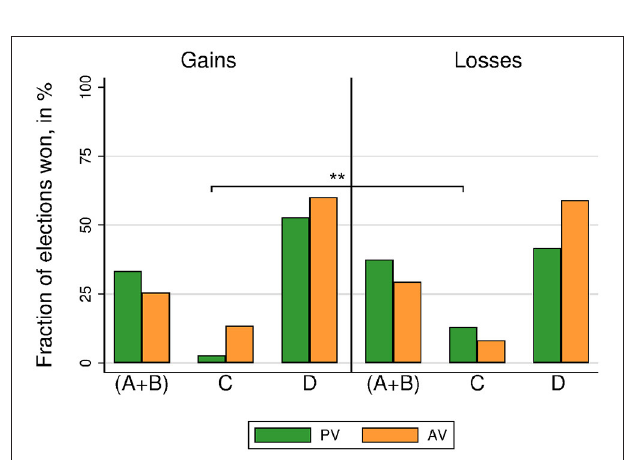
FIGURE 6 | Society 2. Election winners (including tied winners) by voting method and treatment. Stars refer to the significance of non-parametric tests ( ∗∗ p < 0.01 ∗∗∗ p <